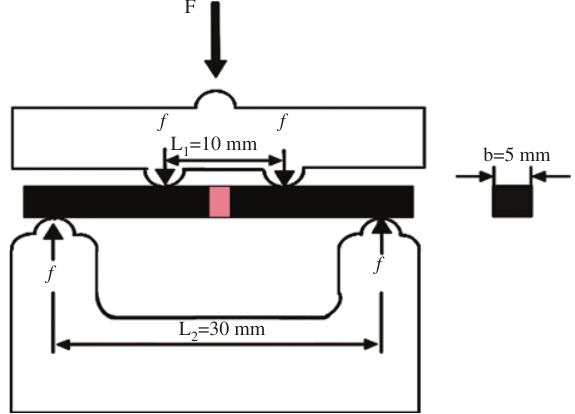
Figure 9: Fracture morphology of the W75-Cu/W55-Cu brazed joint: (A) macro image; (B) micro